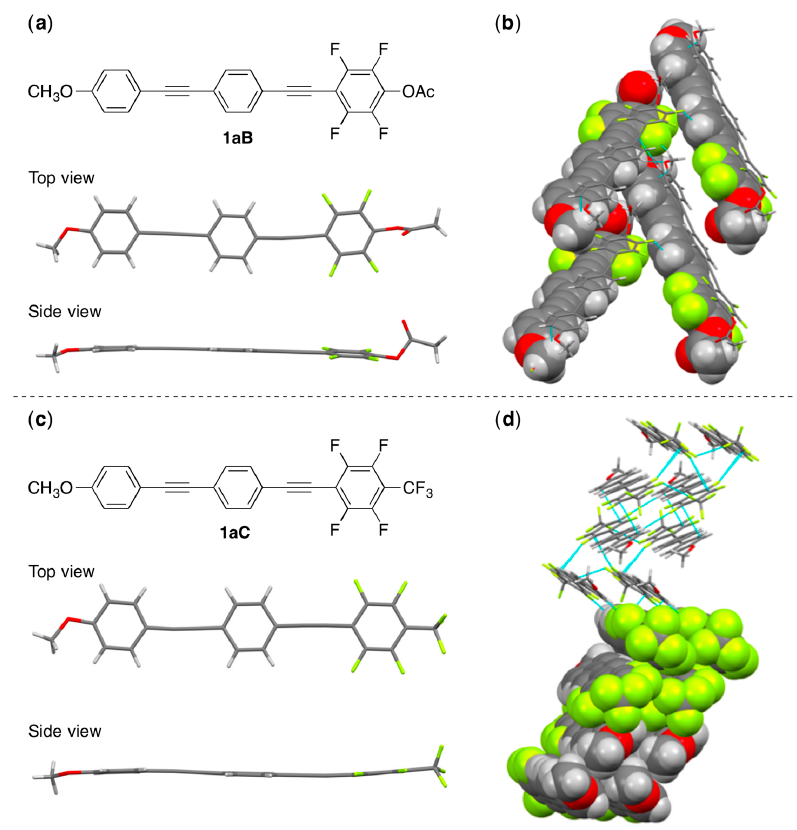
Figure 3. Molecular and crystal structures of ( a ) 1aB and ( c ) 1aC . Packing structures of ( b ) 1aB and ( d ) 1aC . The light-blue lines in the packing structures indicate close contacts shorter than the sum of van der Waals radii (C: 170 pm, H: 120 pm, F: 148 pm).